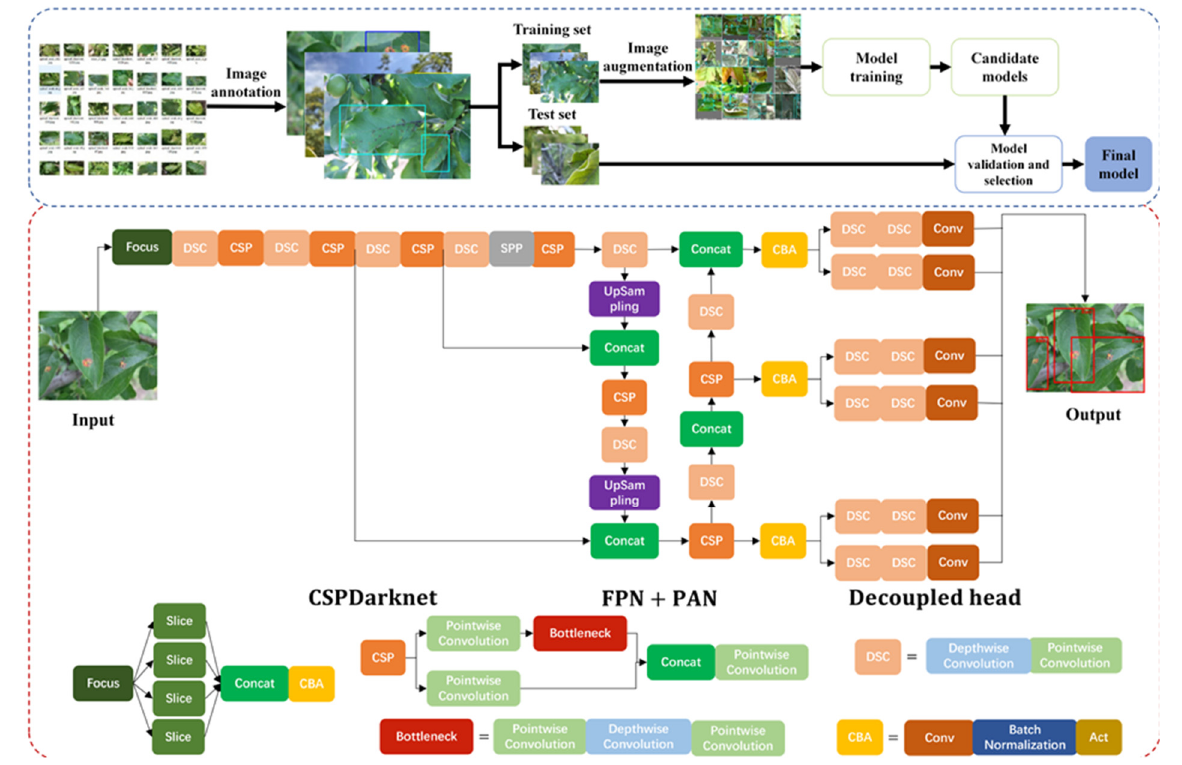
Figure 2. The overall framework for diseased apple leaf detection.